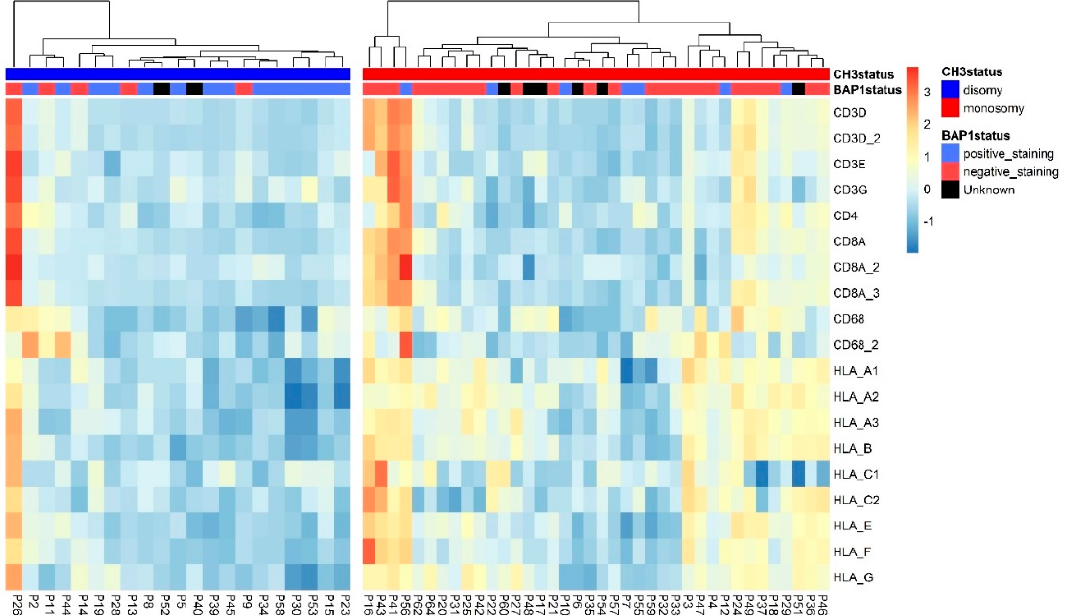
Figure 1. Two heatmaps showing the expression of several infiltrate and HLA Class I markers, normalized per marker over all 59 tumors. On the left is the heatmap of the disomy 3 (D3) tumors ( n = 21) and on the right the heatmap of the monosomy 3 (M3) tumors ( n = 38); tumors are clustered according to the amount of infiltrate and HLA Class I expression. Annotated are the chromosome 3 status (blue for D3 tumors, red for M3 tumors) and BAP1 staining. The presence of positive nuclear staining for BAP1 is indicated in blue (BAP1 is normal), while red indicates no BAP1 staining and black an unknown BAP1 status.